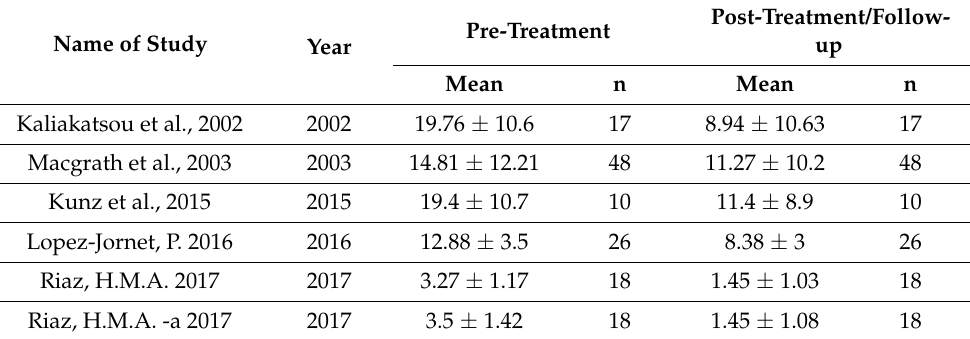
Table 3. Studies that compared Oral Health-Quality of Life (Pre-Post) in oral lichen planus patients before and after intervention plans using the Short-Form Oral Health Impact Profile (OHIP)-14.